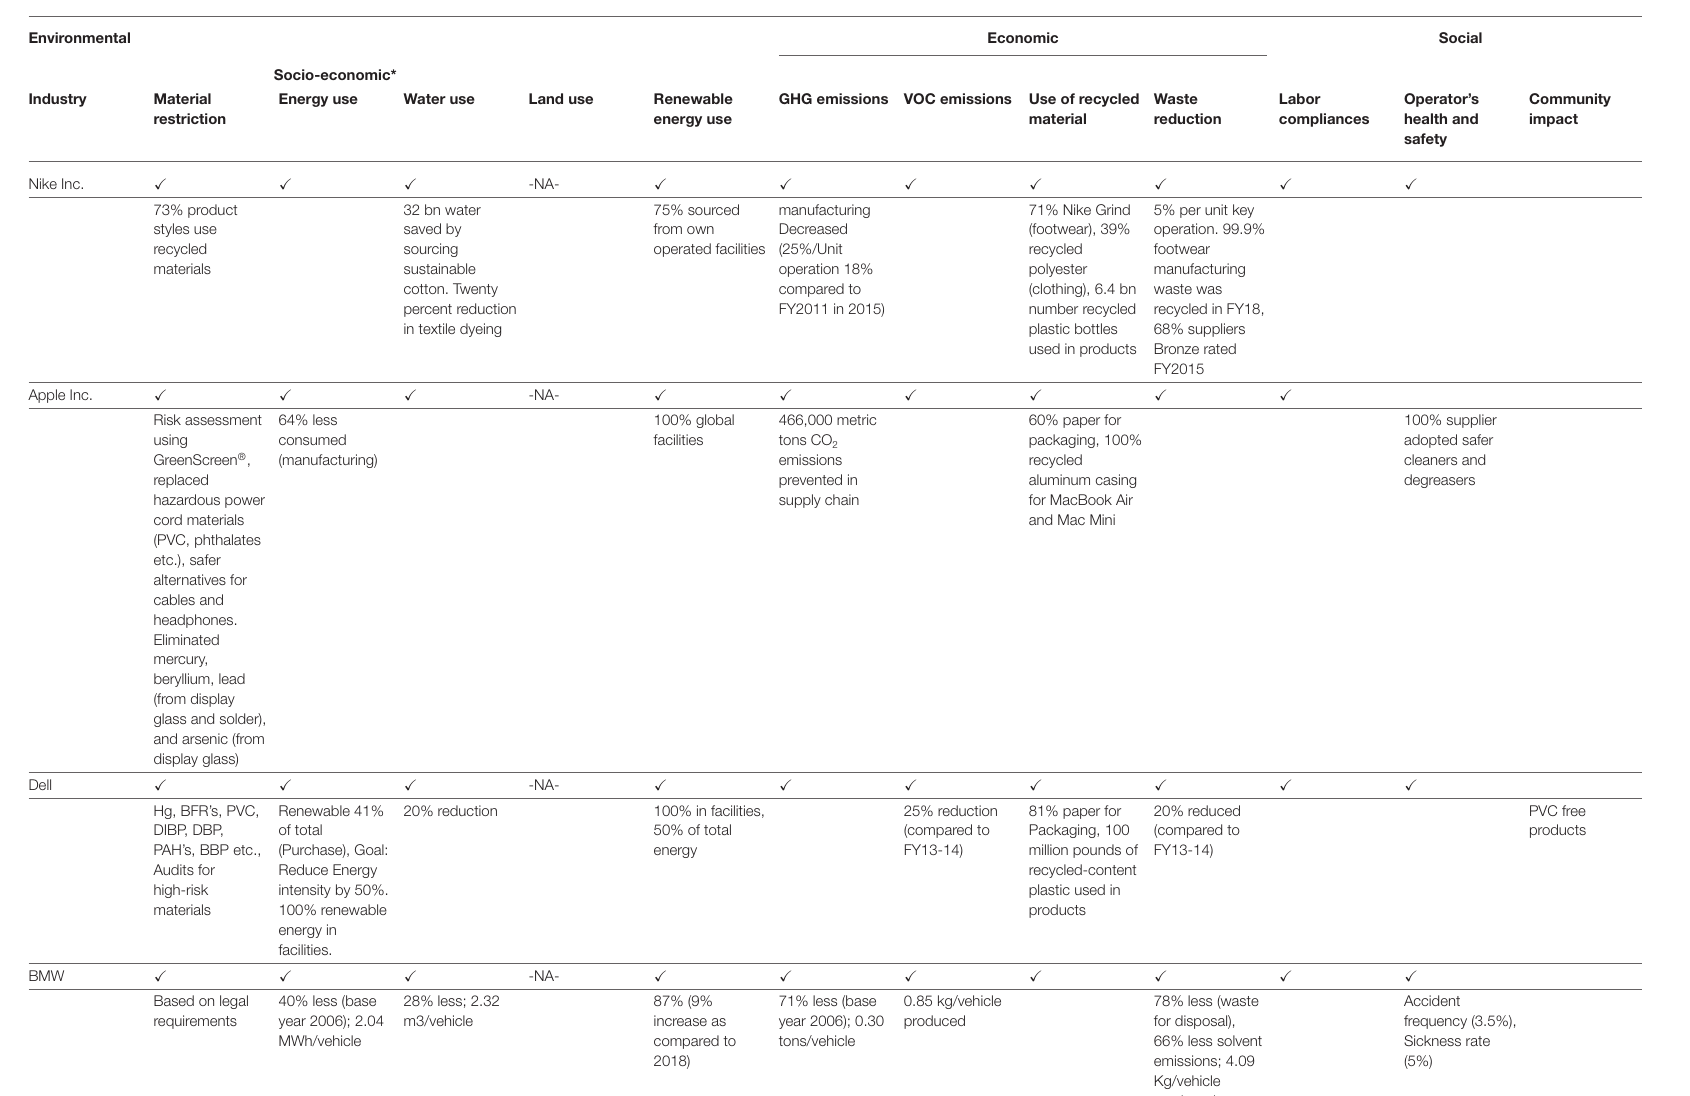
TABLE 5 | Sustainability assessment in industry; compared against effectiveness metrics (partially adapted from Joung et al., 2013). Assessment Criteria Environmental